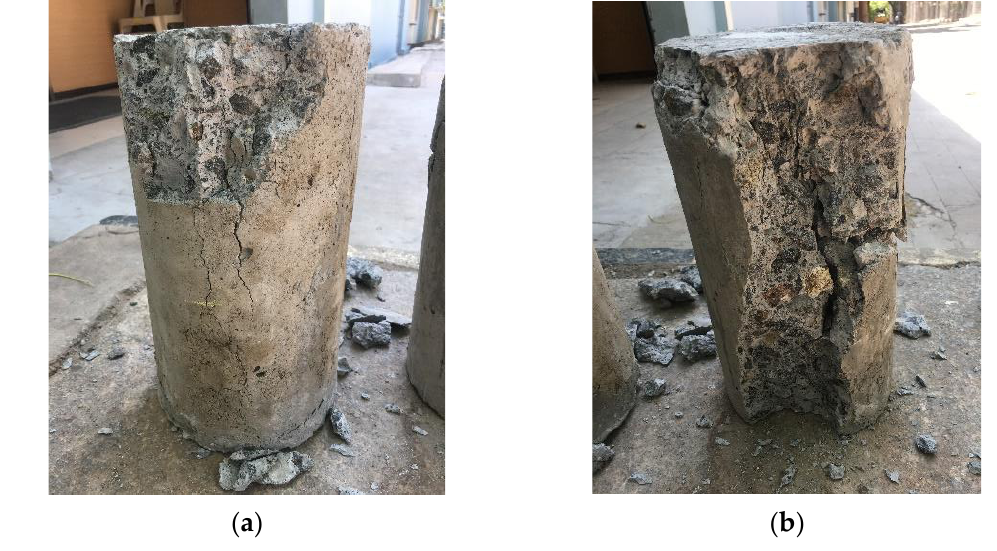
Figure 6. Failure pattern of unconfined specimens ( a ) CS ( b ) CS 400. Table 4. Compression test results of unconfined specimens exposed to elevated temperature.